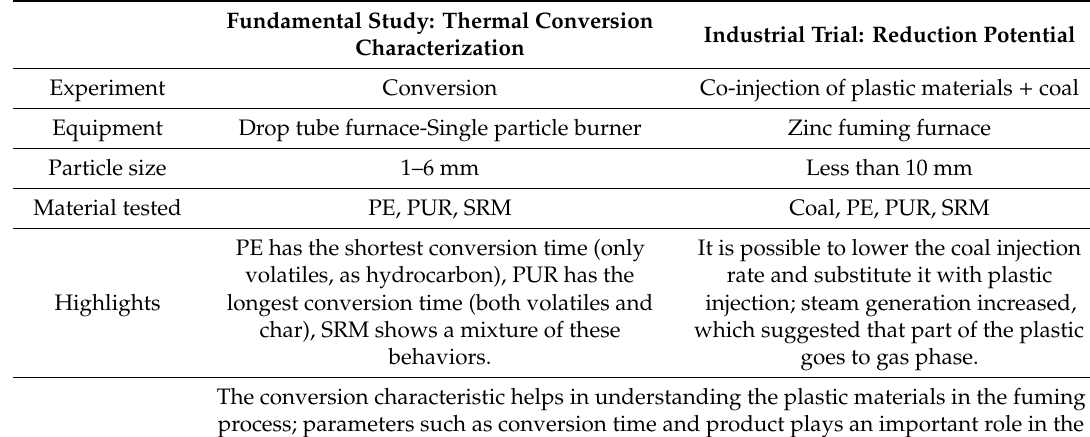
Table 4. Summary of experiments and highlights of